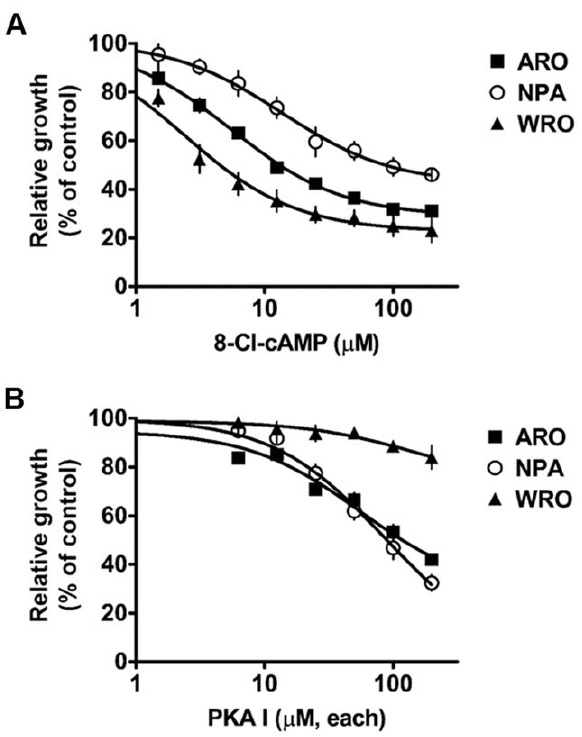
Figure 1. Antiproliferative effect of 8-Cl-cAMP (A) or the PKA I- selective cAMP analogs (B). ARO, NPA and WRO cells were cultured for 72 h in the presence of the indicated concentrations of either type of cAMP analog(s) and cell viability was determined utilizing the MTT assay. PKA I, PKA I-selective analogs used at equimolar concentrations.